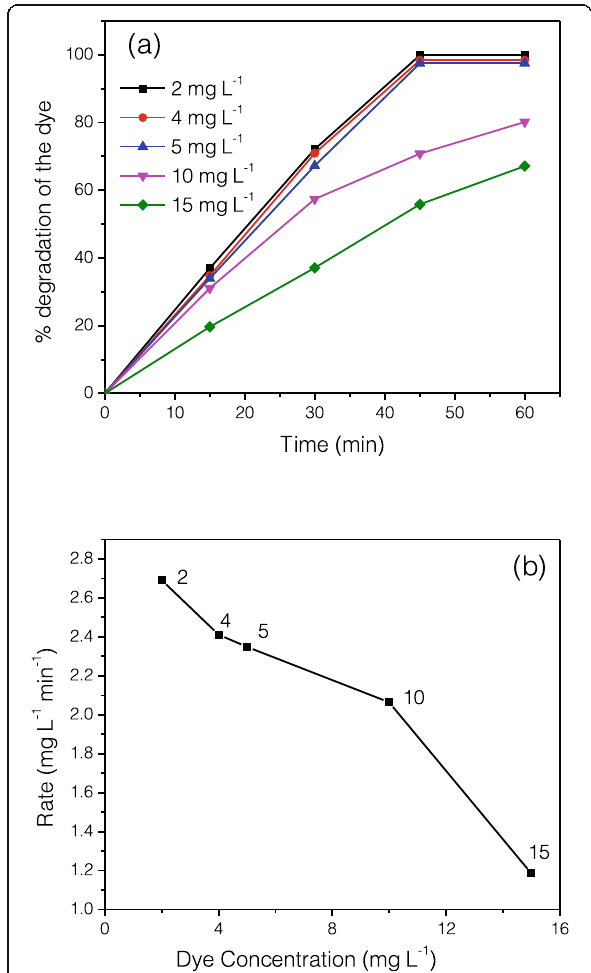
Fig. 11 ( a ) Initial concentration of dye on the rate of degradation of AR 6A, at catalyst dosage of 100 mg L − 1 and pH = 6, ( b ) rate of the degradation on initial dye concentration